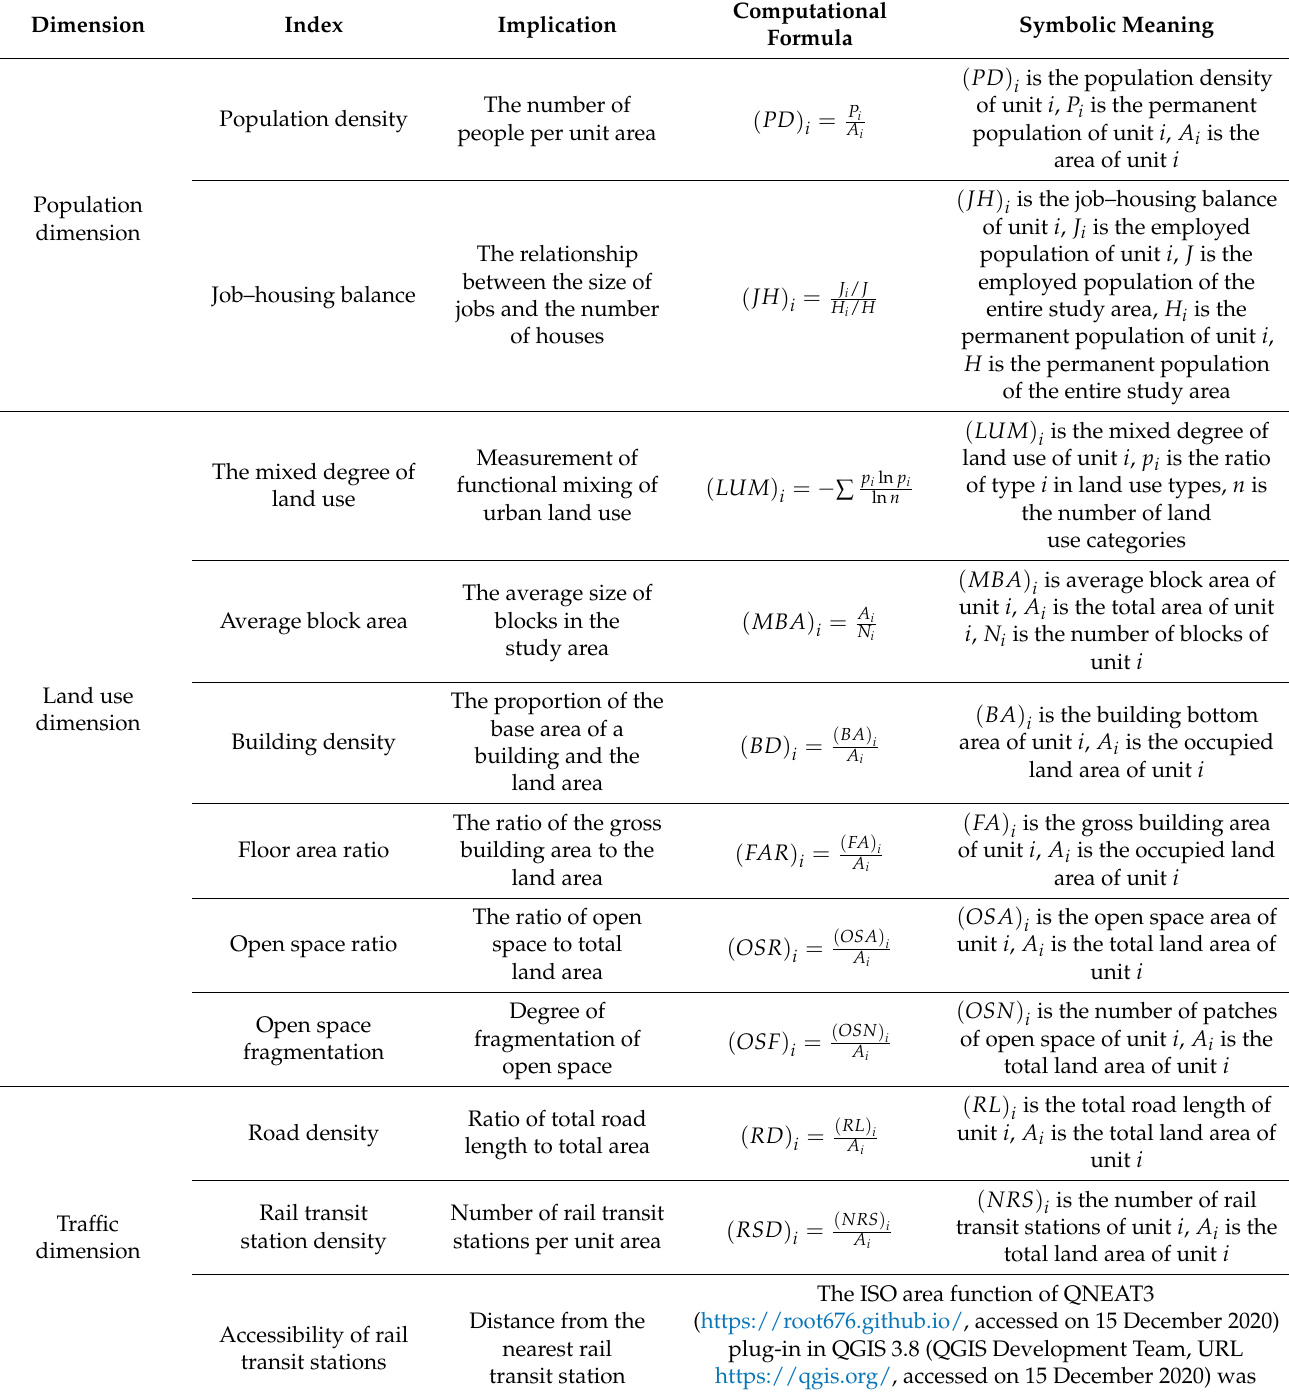
Table 1. Measurement indices of urban spatial